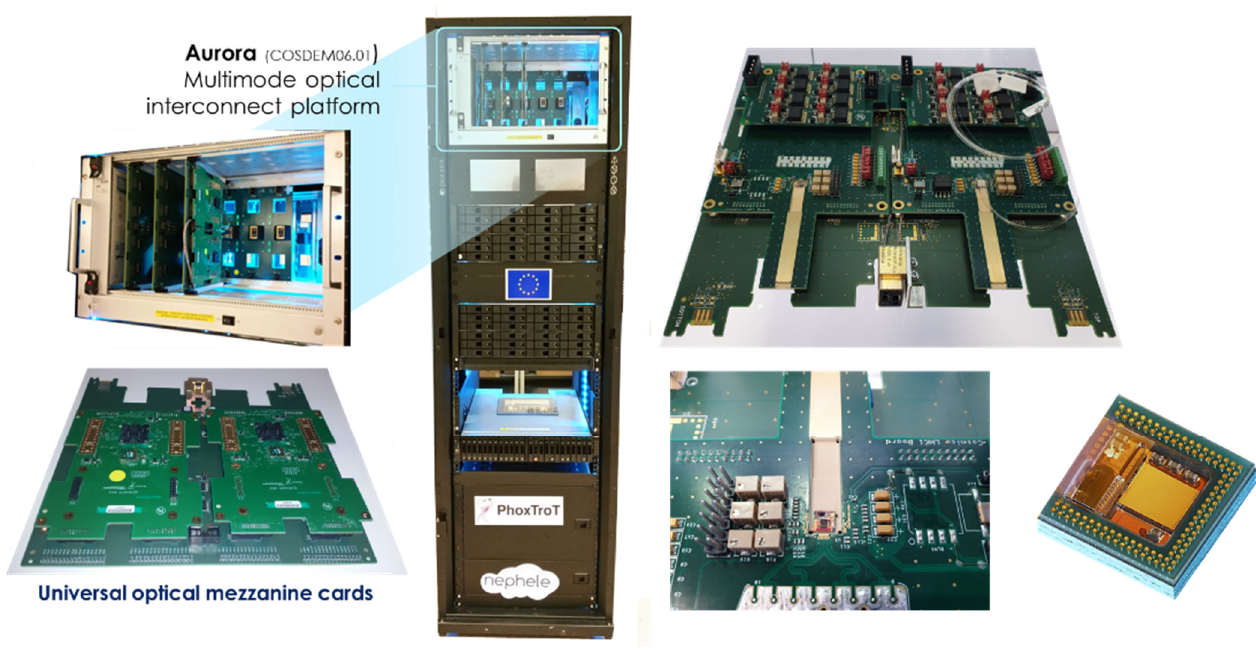
Figure 1. Hyperscale rack-scale demonstrator with H2020 COSMICC “Aurora” platform and test daughtercards with I/O core mezzanine cards connected [5–7] .